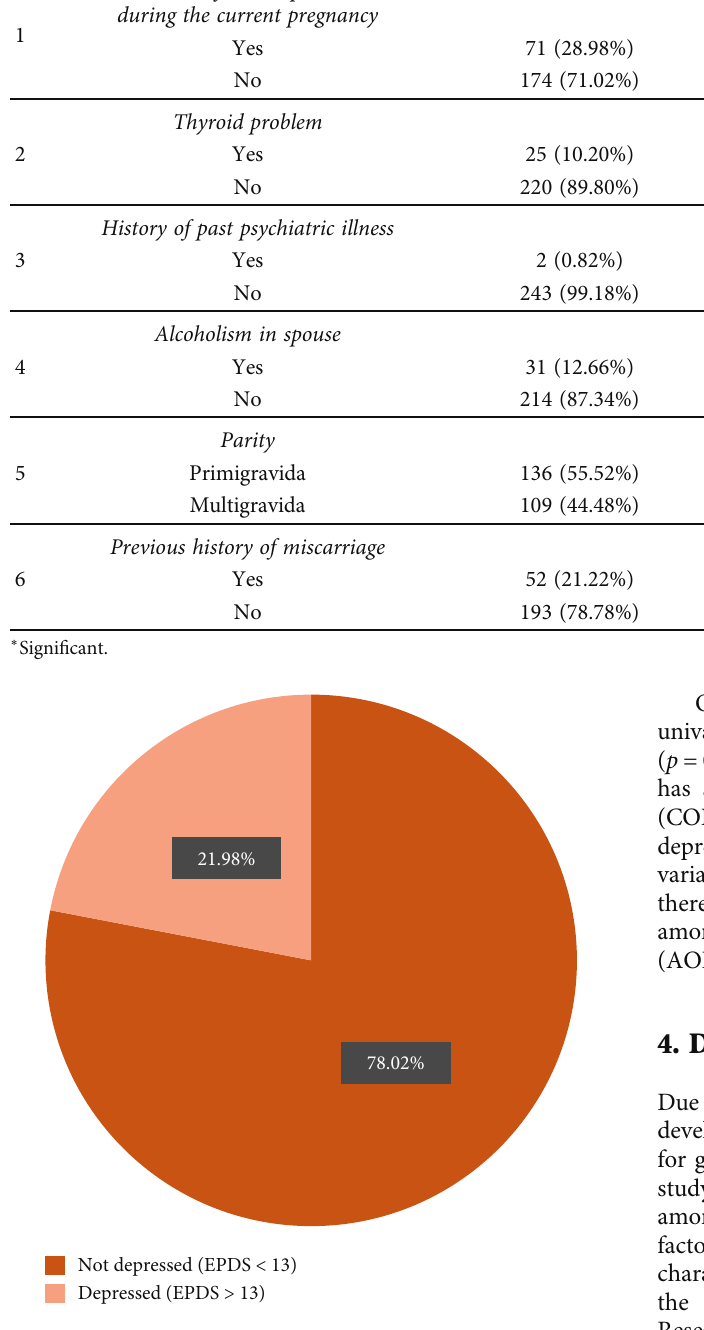
Figure 1: Prevalence of antenatal depression.